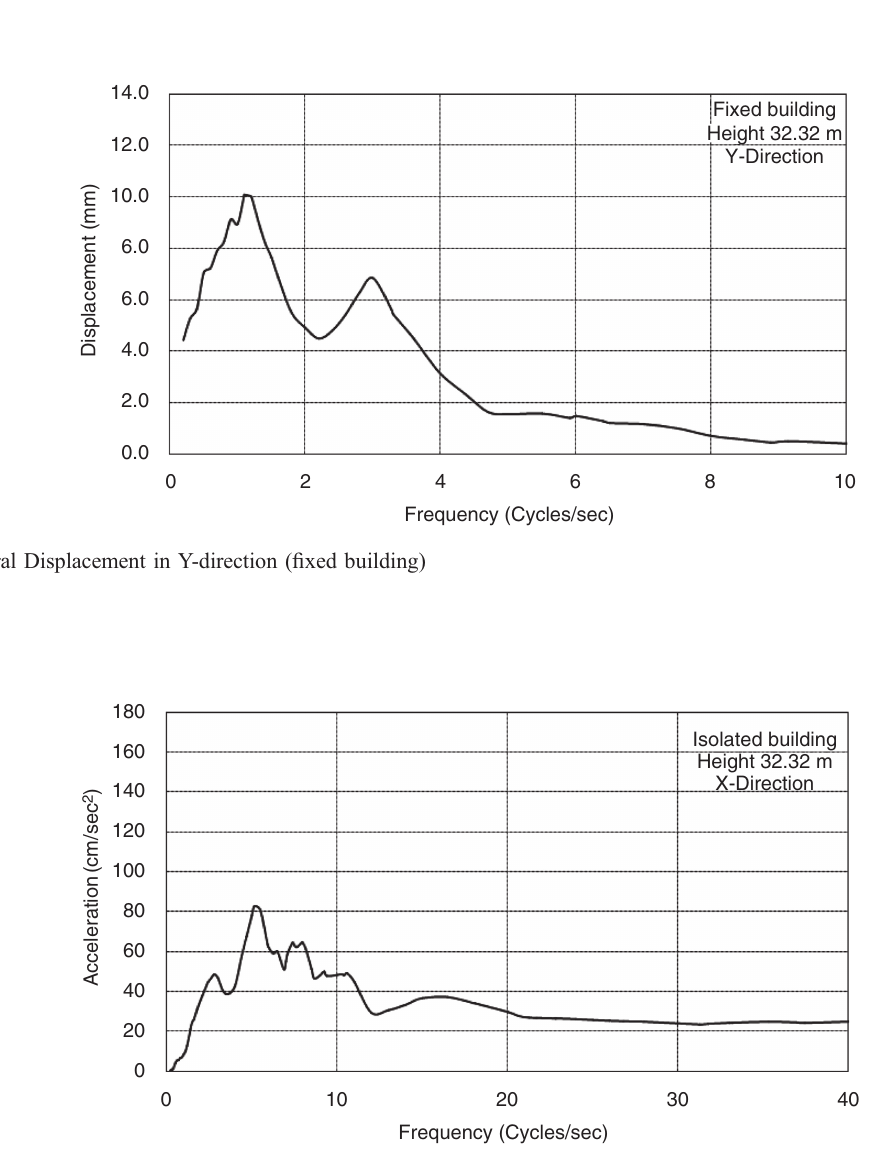
Fig. 12. Spectral Acceleration in X-direction (isolated